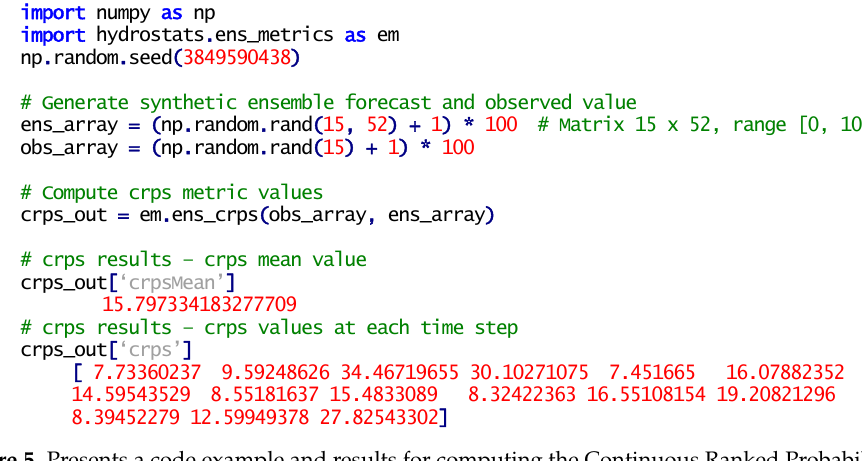
Figure 5. Presents a code example and results for computing the Continuous Ranked Probability Score (CRPS) for an ensemble forecast with 52 realizations and a length of 15. The bottom of the figure shows the CRPS mean, and the CRPS values at each time step.